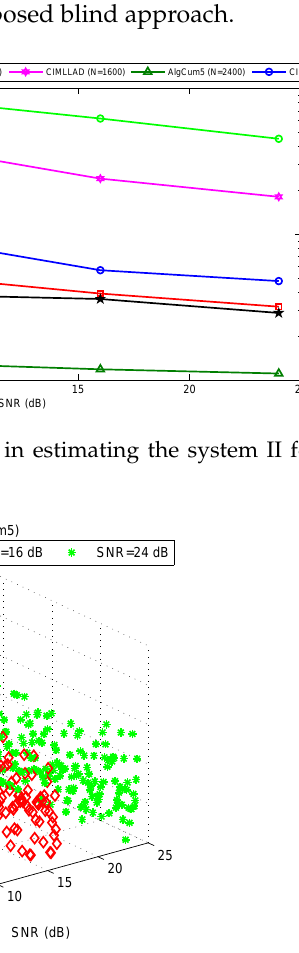
Figure 15. Behavior of the distributions of estimated NMSE using the proposed approach (AlgCum5) in the system II